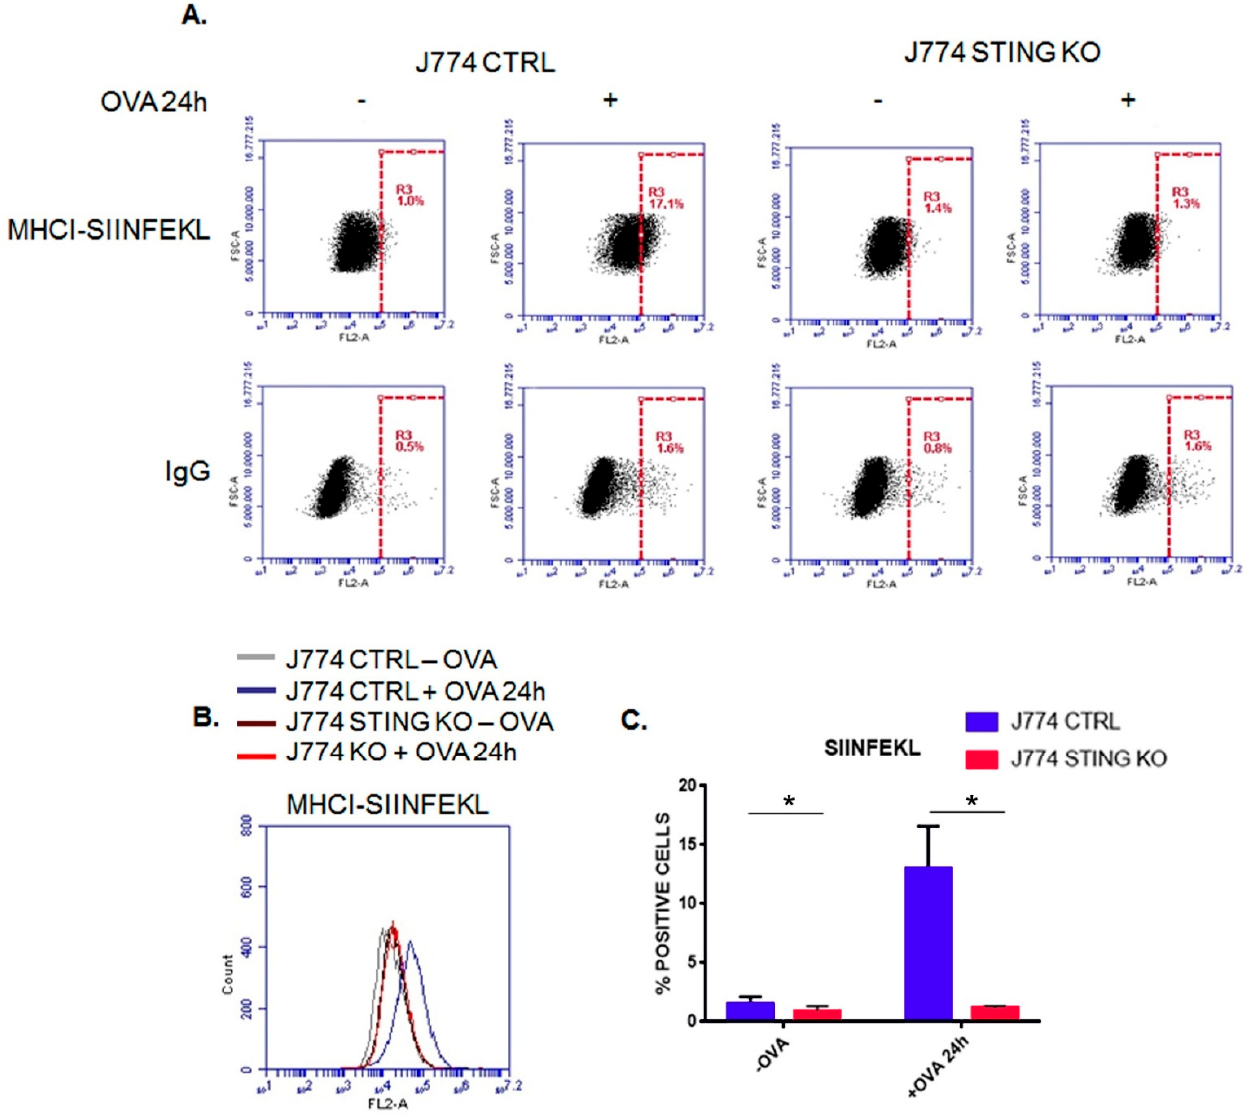
Figure 1. MHC-I-dependent antigen presentation of ovalbumin is impaired in STING KO macrophages. ( A ) J774 CTRL and STING KO (1 × 10 6 ) were treated with 500 µ g/mL of OVA for 24 h and were stained with SIINFEKL/H-2Kb-PE and IgG-PE as a control. Each plot represents 10,000 events of a representative experiment. ( B ) Histogram of J774 CTRL and STING KO treated as above. ( C ) Percentage of SIINFEKL/H-2Kb-positive population in untreated or OVA treated cells. Values (mean ± SE, n = 5) are shown. The asterisks indicate a statistically significant difference compared to the untreated control, according to a Student’s t ‐ test ( p < 0.01).